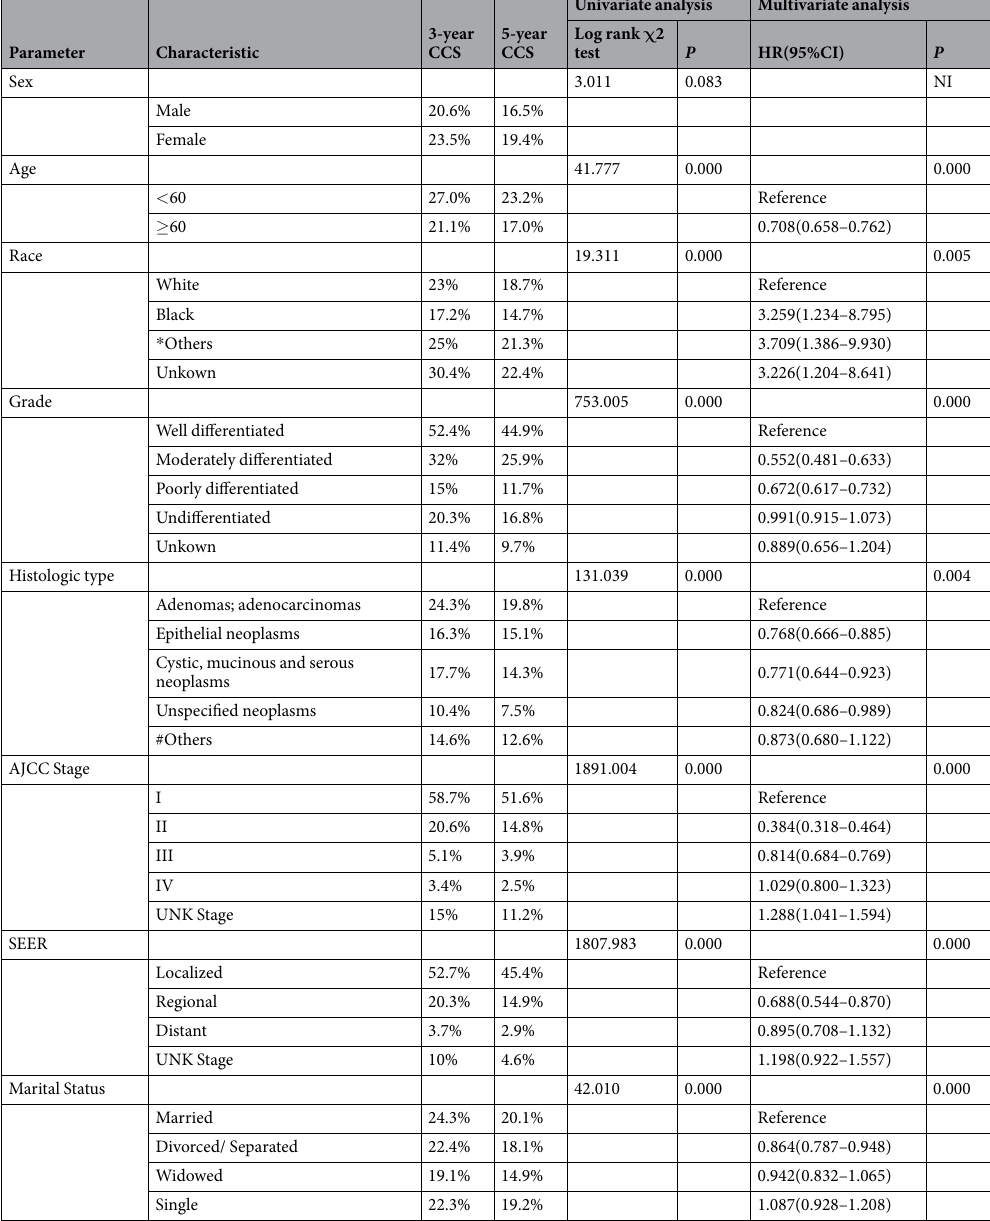
Table 2. Univariate and multivariate survival analysis for evaluating the influence of marital status on CSS of GBC patients in SEER database. * Other includes American Indian/AK Native, Asian/Pacific Islander. # Other includes squamous cell carcinoma/complex epithelial neoplasms/complex mixed and stromal neoplasms/ductal and lobular neoplasms. NI: not included in the multivariate survival